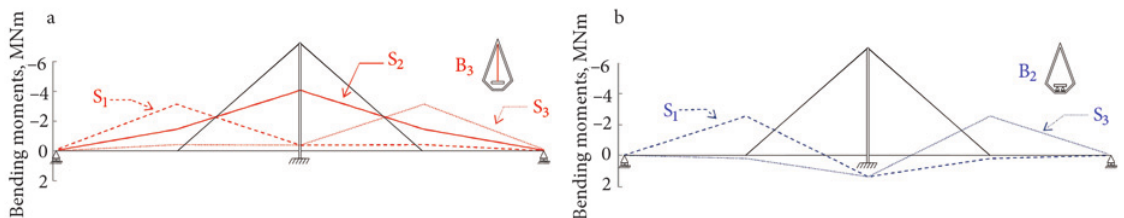
fig. 4. Bending moments produced by unitary strains in stays S 1 , S 2 and S 3 in cable-stayed bridges B 3 (a) and B 2 (b)